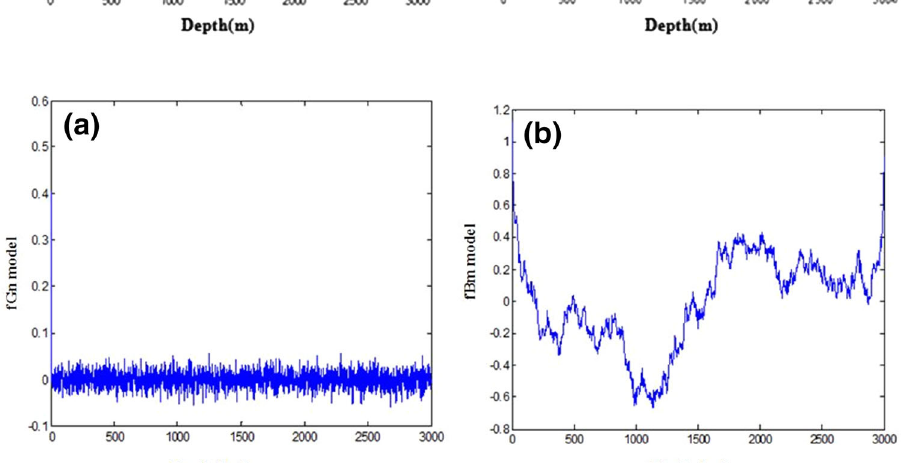
Fig. 7 Two realizations with fractal structure for well log porosity in well C; (H =